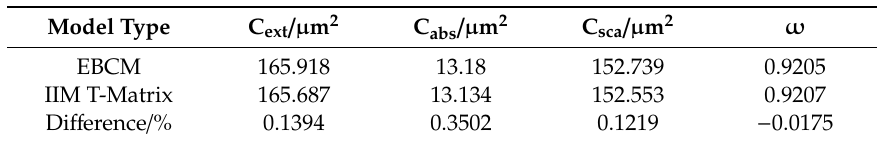
Table 2. The integral scattering parameters calculated by the IIM and EBCM T-Matrix methods for the large spheroidal